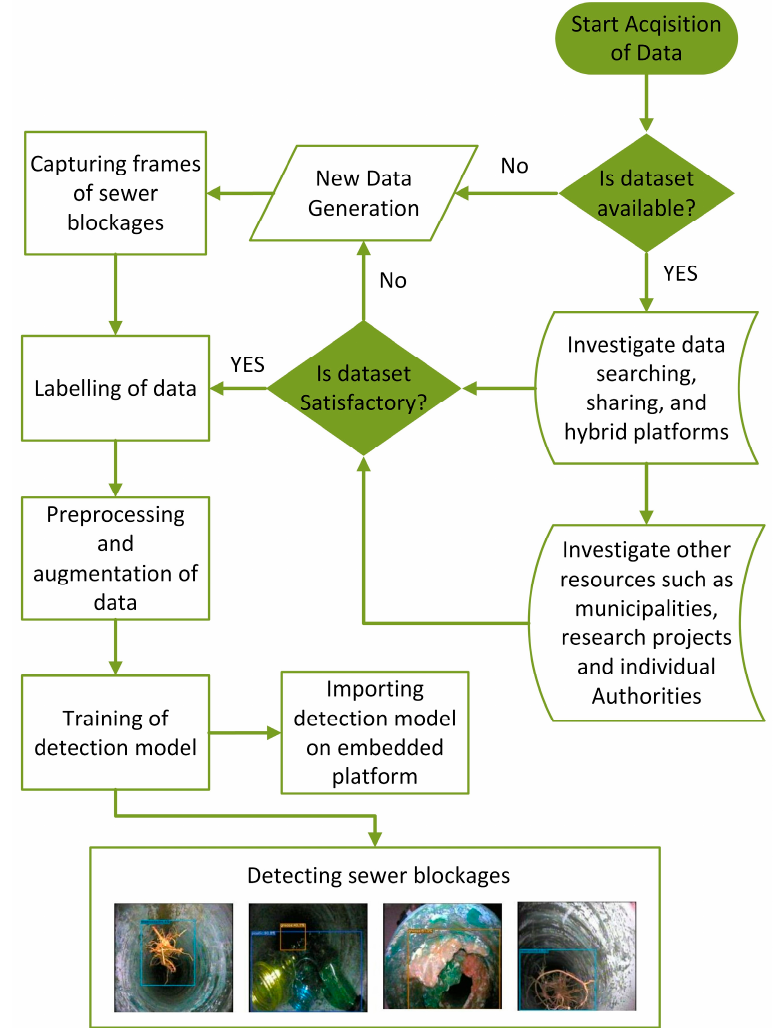
Figure 1. Workflow diagram of the presented S-BIRD dataset.